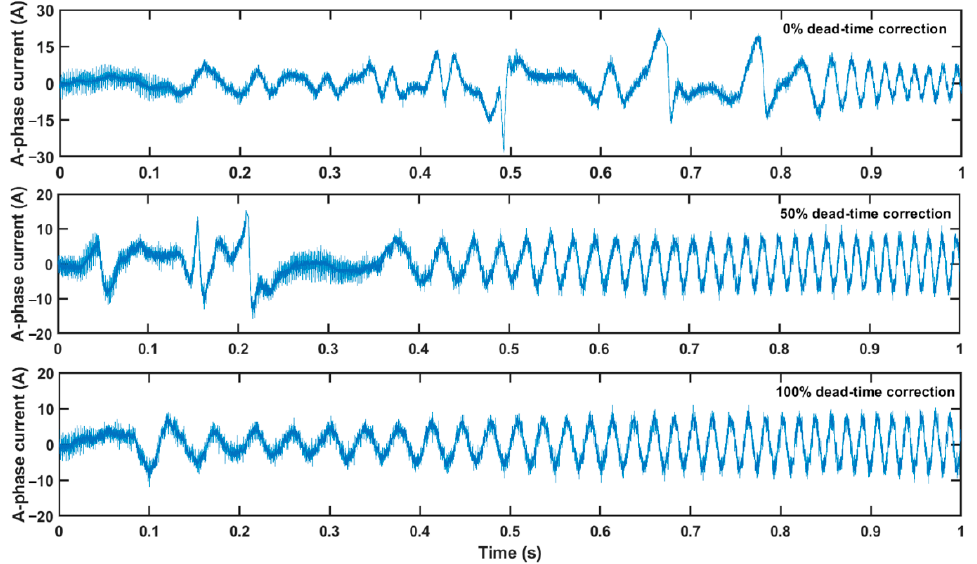
Figure 10. A-phase current with different dead-time correction.